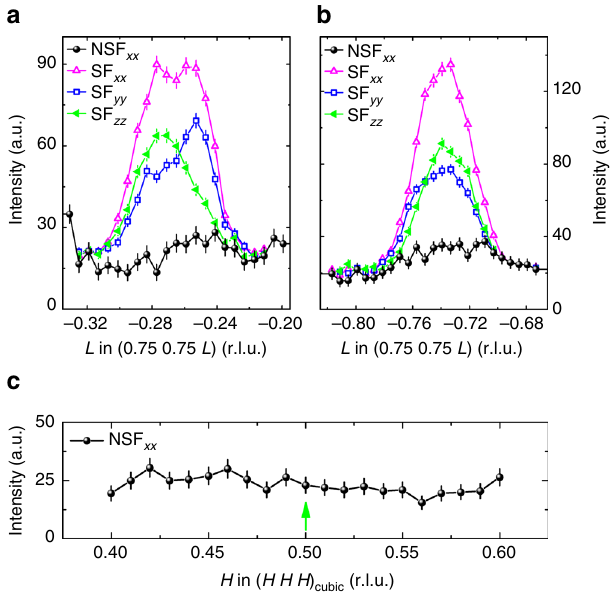
Fig. 4 Polarized neutron-diffraction measurements. a , b Polarized neutron scattering experiments for the LaNiO 3 single crystal at 2K. Spin- fl ip (SF) and non-spin- fl ip (NSF) channels were measured for neutron spins parallel to the scattering vector ( x -direction), perpendicular to the scattering plane ( z - direction) or perpendicular to x and z ( y -direction). c A structural scan at 2K showing no indications for any charge ordering peak at the (0.5 0.5 0.5) position in pseudocubic notation (indicated by the green arrow). The intensity error bars are statistical error bars calculated by the square root of